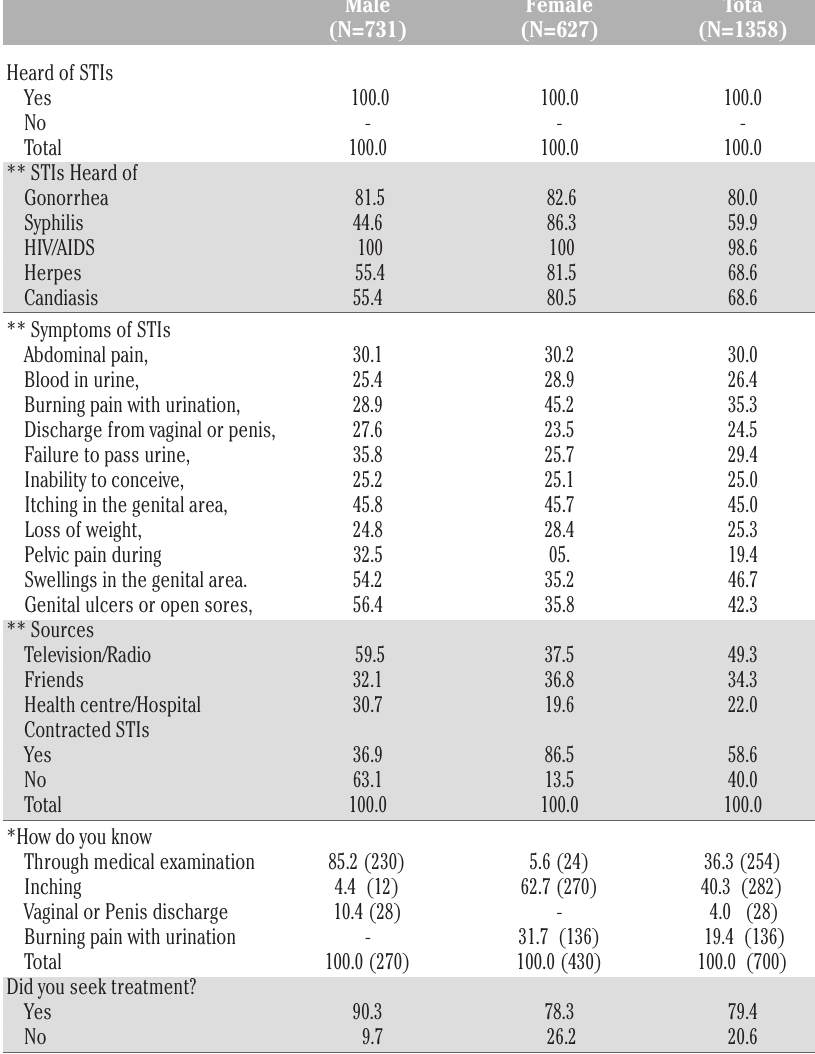
Table 3. Distribution of gender differences in STI Knowledge.